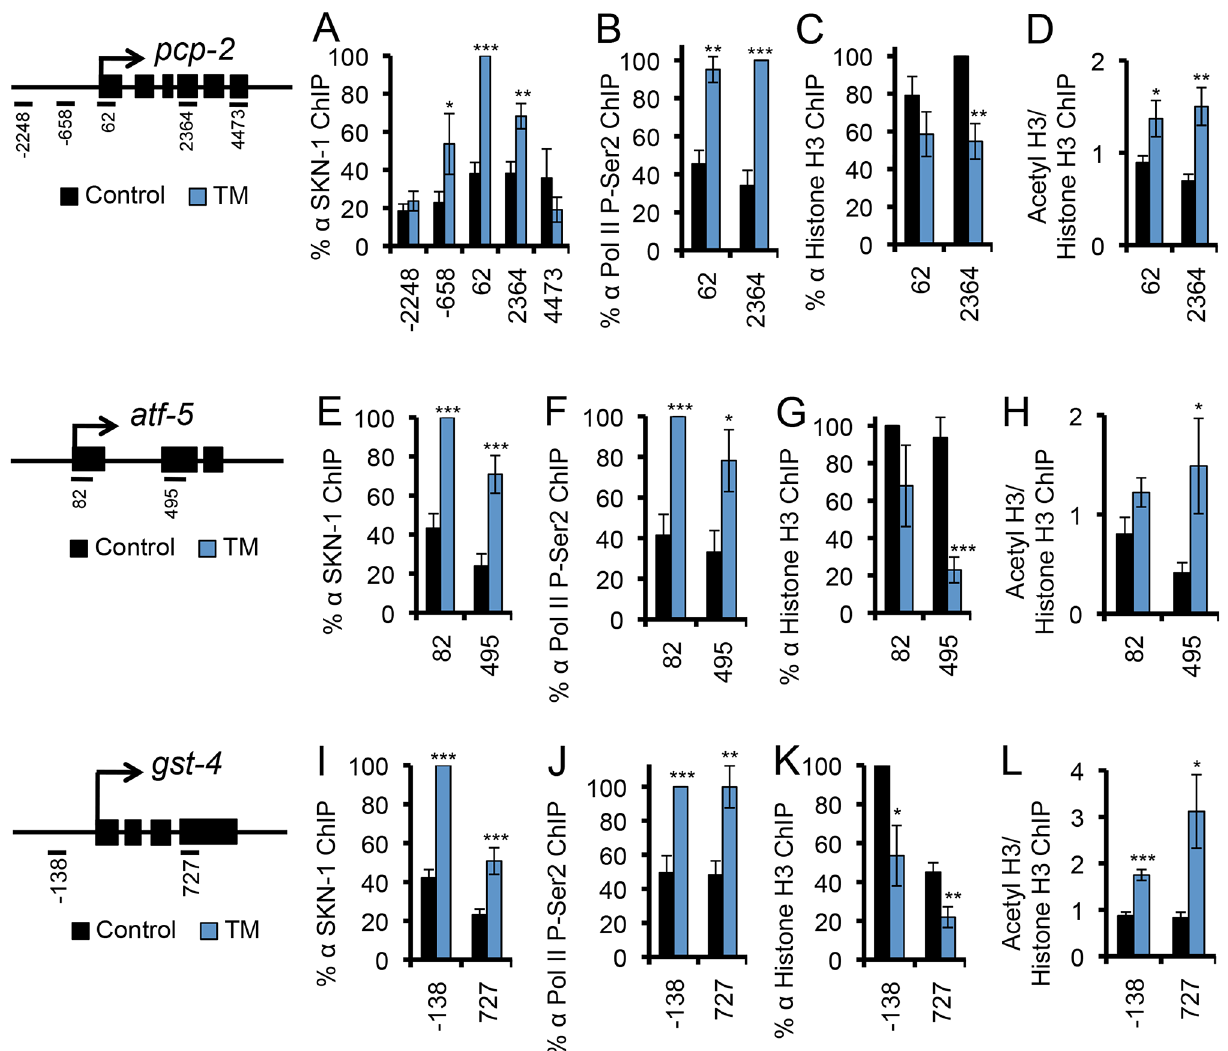
Figure 2. SKN-1 directly regulates target genes during the UPR. (A–L) ER stress-induced SKN-1 recruitment and transcriptional activation was analyzed at the SKN-1-regulated genes pcp-2 (A–D), atf-5 (E–H), and gst-4 (I–L). TM treatment leads to SKN-1 recruitment (A, E, I), accumulation of Pol II that is phosphorylated at CTD Ser 2 (P-Ser2) (B, F, J), decreased Histone H3 occupancy (C, G, K), and increased H3-AcK56 density (D, H, L) at the site of transcription. Maps mark qPCR amplicons relative to the predicted transcription start site, with exons marked as black boxes. % ChIP signal is relative to input, and normalized to the highest signal for each run [44]. In (D, H, L), a ratio of acetyl histone to histone signal is presented. For ChIP experiments in this study error bars represent SEM, and * p # .05, ** p # .01, *** p # .001, relative to pL4440 Control calculated using one-sided student’s t-test. See also Figure S2.